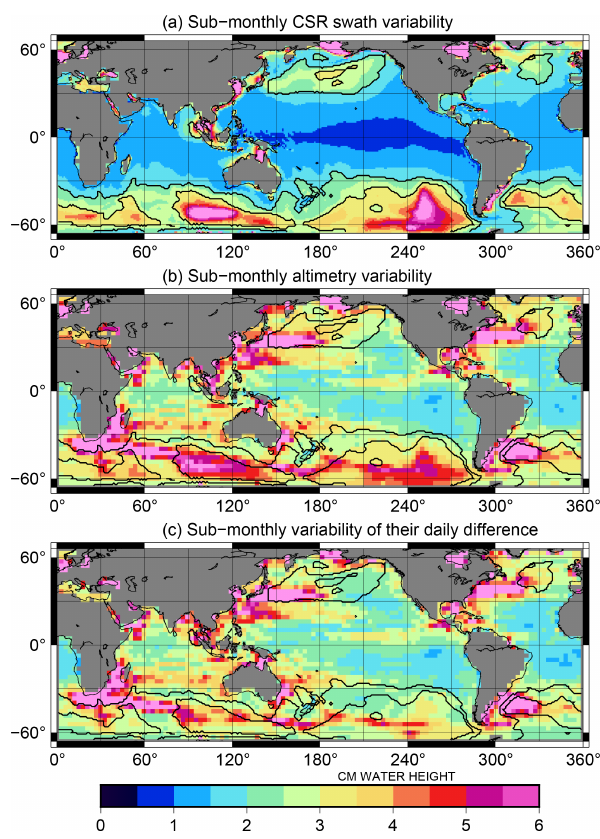
Figure 2. Standard deviation of (a) CSR swath sub-monthly ocean bottom pressure, (b) Jason altimetry sub-monthly sea surface height anomalies, and (c) the difference between the two series during 2002–2016. Units are centimeters of water height in all cases. For comparison’s sake, all plots include the 2 and 3cm contour lines computed from the CSR swath plot (a) .